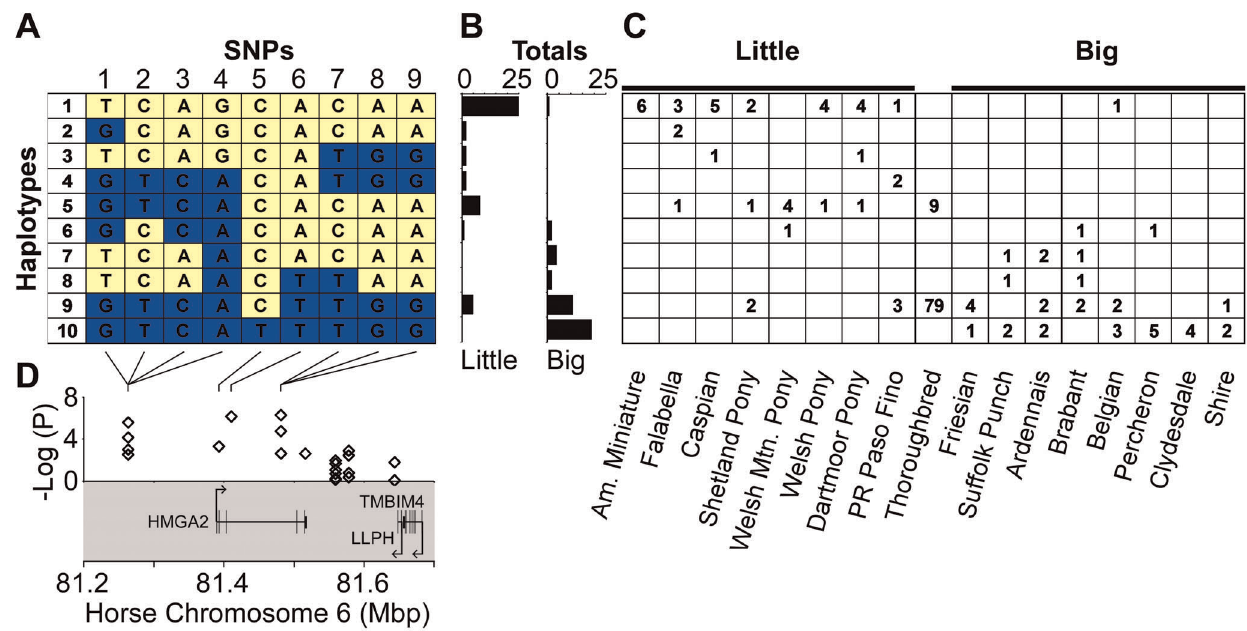
Figure 4. Association with size at the HMGA2 locus. (A) Haplotypes spanning HMGA2 were inferred with PHASE for a set of nine SNPs that included all size-associated SNPs at the locus. (B) The haplotype counts differ in the set of all little breed horses (American Miniature to Puerto Rican Paso Fino) vs. all big breed horses (Friesian to Shire). (C) For each breed, the count of chromosomes inferred to be carrying that haplotype. (D) Size- associated SNPs occur within and adjacent to HMGA2 . SNP associations from the 16-breed GWA scan are plotted above the genes in this locus. These SNPs were discovered and genotyped by capillary sequencing (see main text). Each gene’s exons (vertical bars), introns (horizontal lines) and direction of transcription (arrow) are